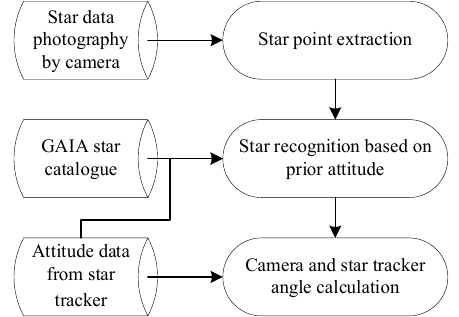
Figure 2 . Processing flowchart of the star observation